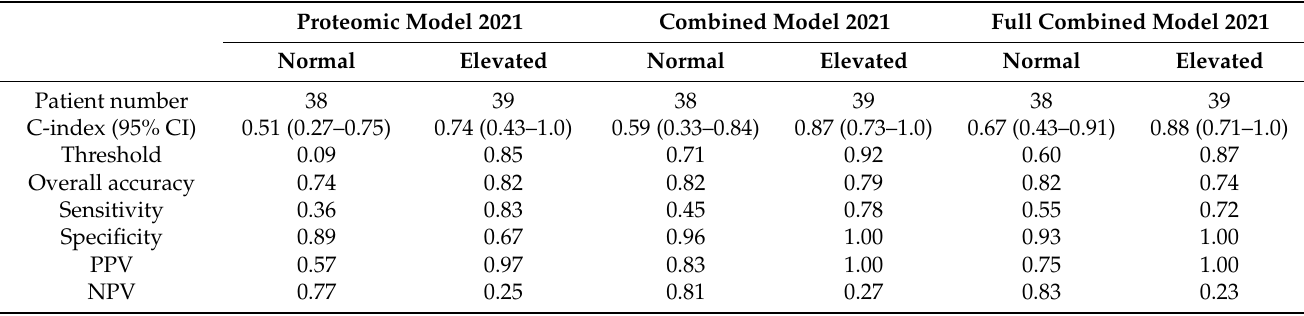
Table 4. Diagnostic performance broken down by CA125 (cutoff 35 U/mL).